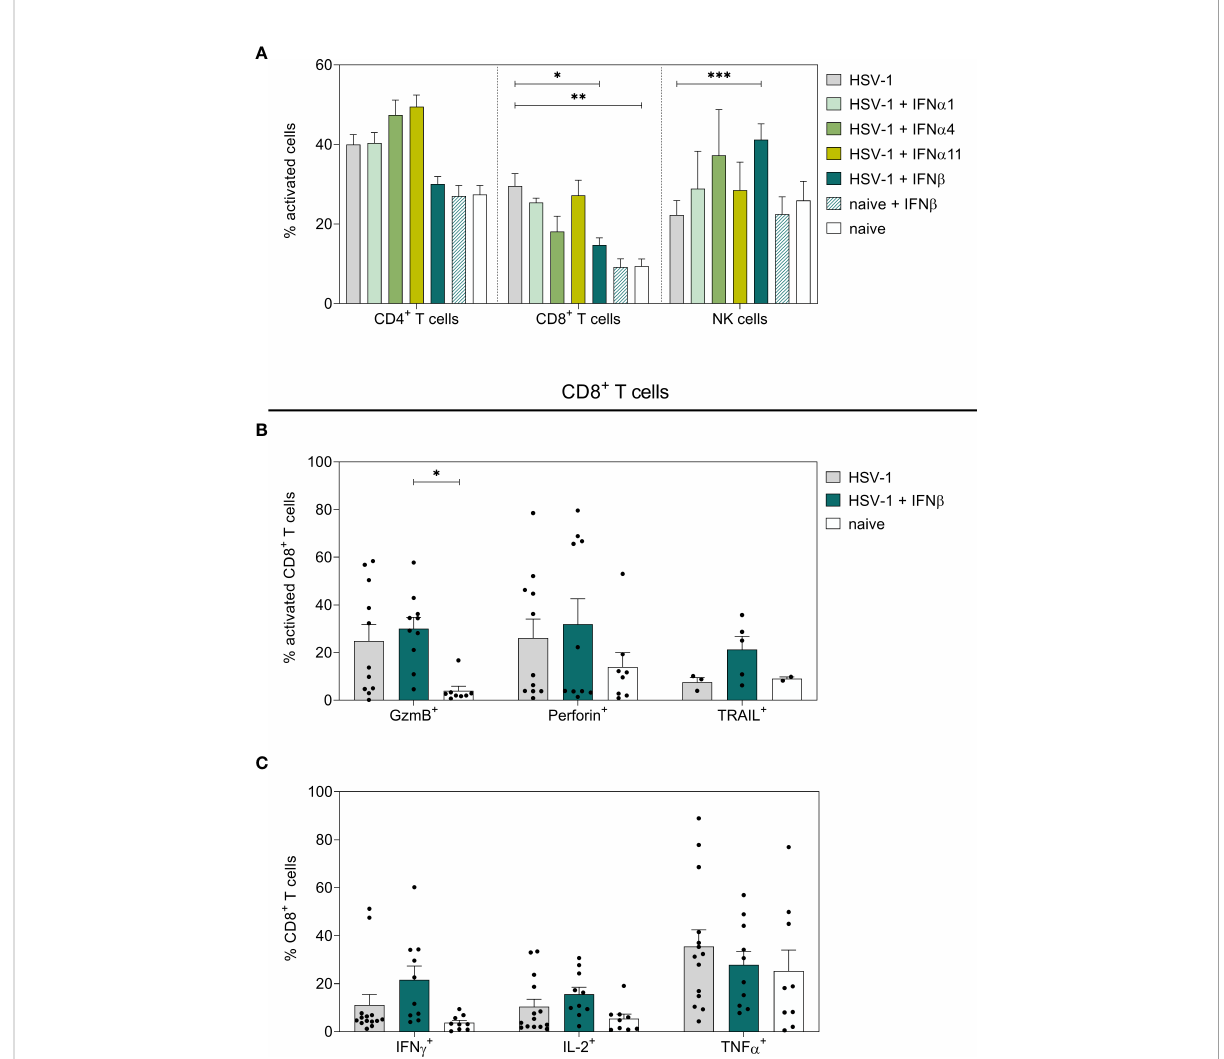
FIGURE 2 Peripheral immune responses in the spleen on day 8 post HSV-1 infection. Female C57BL/6 mice were infected with 1×10 7 TCID 50 of HSV-1 F for eight days or left uninfected (naive control). Mice were treated with 8000 U of murine IFN a 1, IFN a 4, IFN a 11, and IFN b for six consecutive days starting on day 2 p.i. or left untreated (HSV-1). On day 8 p.i. , splenic lymphocytes were isolated from dissected spleens. For fl ow cytometric analysis, isolated cells were subsequently stained for respective cell surface and intracellular markers. (A) Frequencies of activated CD4 + T cells, CD8 + T cells, and NK cells as well as (B) respective percentage of cytotoxic CD8 + T cells and (C) cytokine-secreting CD8 + T cells are shown. Data points represent individual mice; bars indicate the mean values ± SEM for each group (HSV-1 n = 3-14 mice, HSV-1 + IFN a 1 n = 5 mice, HSV-1 + IFN a 4 n = 3-5 mice, HSV-1 + IFN a 11 n = 6-8 mice, HSV-1 + IFN b n = 5-10 mice, naive + IFN b n = 4 mice, naive n = 2-9 mice). Statistical analyses were conducted via 2way ANOVA and Tukey ’ s multiple comparison test. Statistically signi fi cant differences among all study groups are depicted by * P < 0.05, ** P < 0.01, *** P <